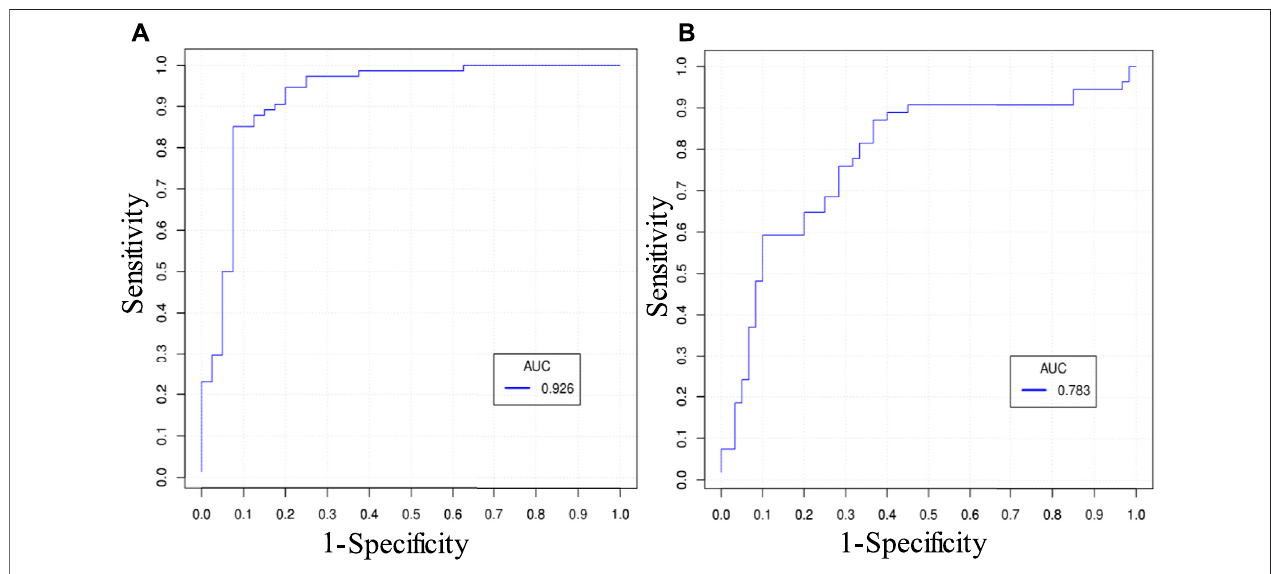
FIGURE 5 | ROC curves of the best combinations of predictors predicting Δ MinCapT. (A) ROC curve using IO data. The best combination is given by PA + MinCapT + MeanCapS + PB. (B) ROC curve using IVUS data. The best combination is given by PA + MinCapT + MeanCapT + MeanCapS + MeanCapSn.